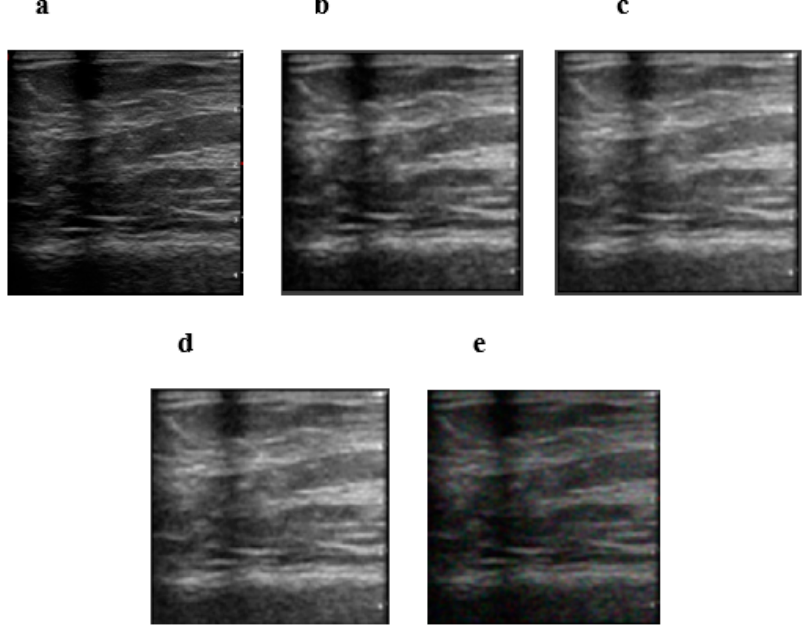
Figure 5. Visual results for clinical data. Performance of the four methods at σ = 20. ( a ) Original image; ( b ) RIBM-NLM method; ( c ) ONLMF; ( d ) NLMF; ( e ) SBF. RIBM-NLM, rotationally invariant block matching based non-local means filter; NLMF, non-local means filter; ONLMF, optimized non-local means filter; SBF, switching bilateral filter.